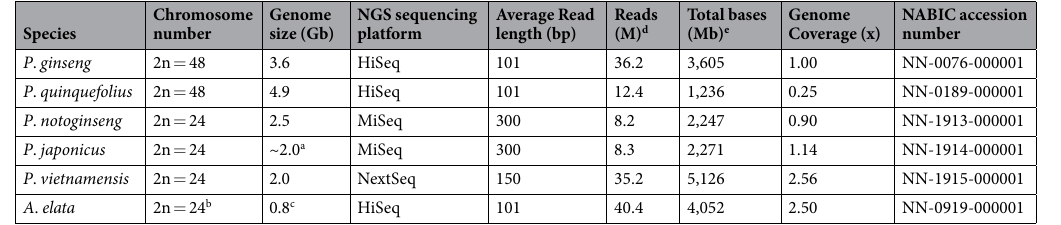
Table 2. Summary of WGS data of five Panax species and the related A . elata used for a survey of major repeats. aGenome size was estimated in the present study. b Chromosome number was determined by DAPI (4 ′ ,6-diamidino-2-phenylindole) staining (Supplementary Fig. S2). c The genome size of A . elata was considered to be approximately 0.8 Gb in this study, based on the genome sizes of related species 51 . d,e Quality-controlled WGS reads were used in the current study.